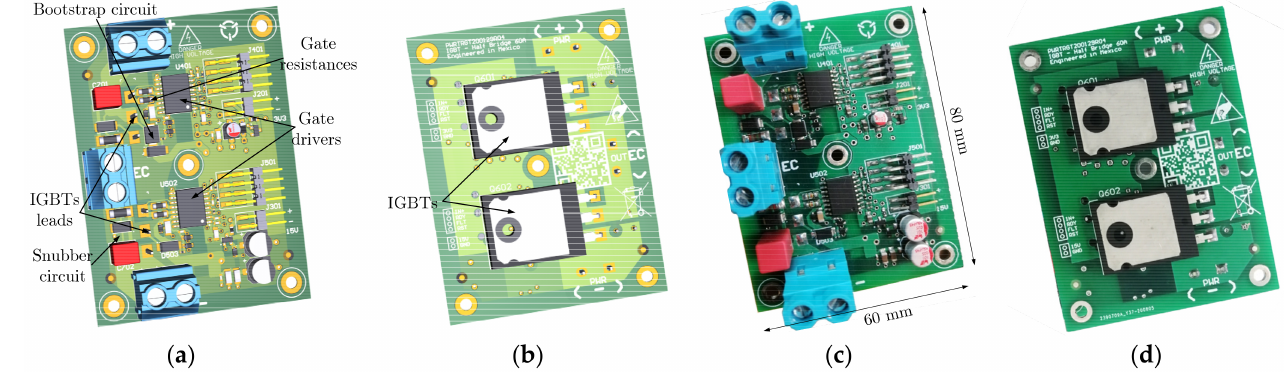
Figure 11. Developed HB cell: ( a ) 3D model, top view; ( b ) 3D model, bottom view; ( c ) implemented prototype, top view; ( d ) implemented prototype, bottom view.